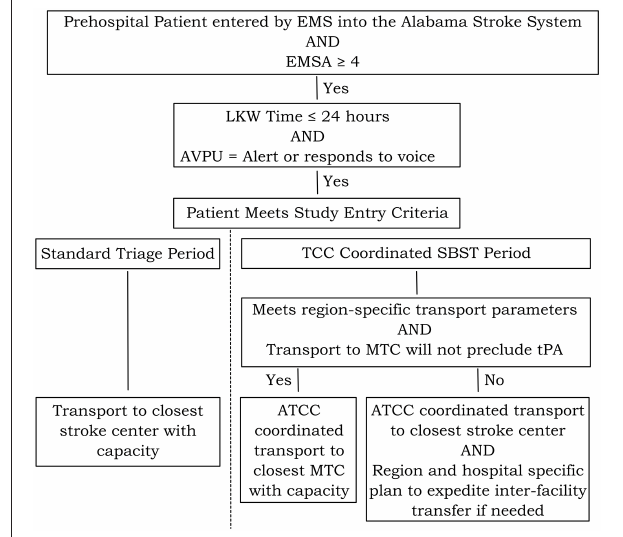
FIGURE 3 | Flow of patients during study. The study will include prehospital patients entered into the stroke system by EMS with an EMSA ≥ 4. Patients with a time last known well (LKW) > 24h or those who respond only to pain or who are unresponsive will be excluded. During the standard triage period, patients meeting study entry criteria will be transported to the closest stroke center with capacity. During TCC Coordinated SBST, patients will be routed by TCC directly to a MTC (including comprehensive stroke centers and thrombectomy-capable primary stroke centers) if additional transport time complies with region-specific transport time limits and will not preclude use of tPA. Otherwise, TCC will coordinate transport to the closest stroke center